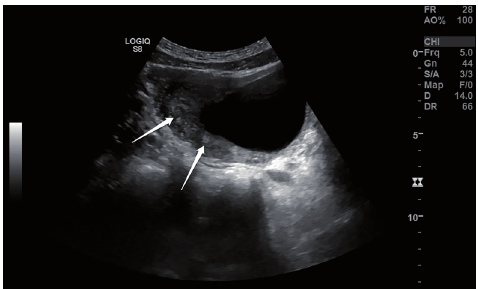
Figure 1 - Ultrasound imaging; diffuse thickening of the anterosuperior and posterior walls of the bladder and multiple round, <5mm nodular echogenities in the thickened walls marked with arrows.